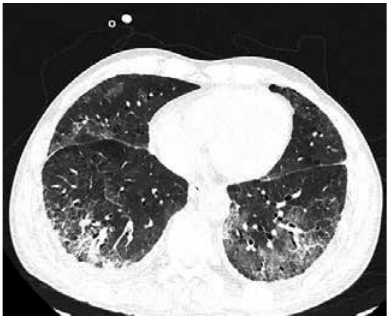
Figure 4 64-year-old male with history of recent travel to Wuhan and laboratory-confirmed SARS-CoV-2 presented with fever. CT images of score 10.9 showed honeycombing opacity that most appeared at subpleural areas of bilateral pulmonary. There also appeared diffuse ground-glass opacities change mixed with a hint of consolidative opacities and slight effusion in the right pleural cavity. Emphysema change displayed since the patients had a 10-year history of chronic obstructive pulmonary